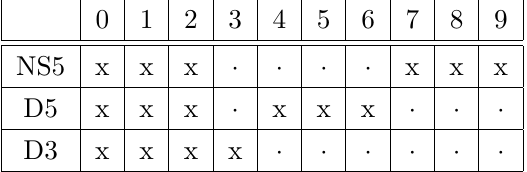
Table 1 . Basic Type IIB brane